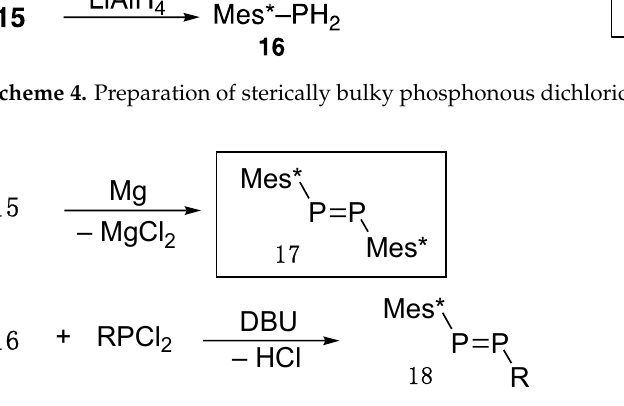
Table 1. Some physical data of diphosphene 17 .